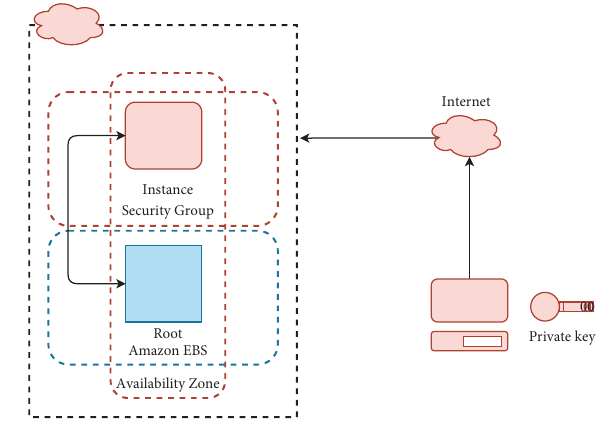
Figure 7: AWS EC2 frewall [31].